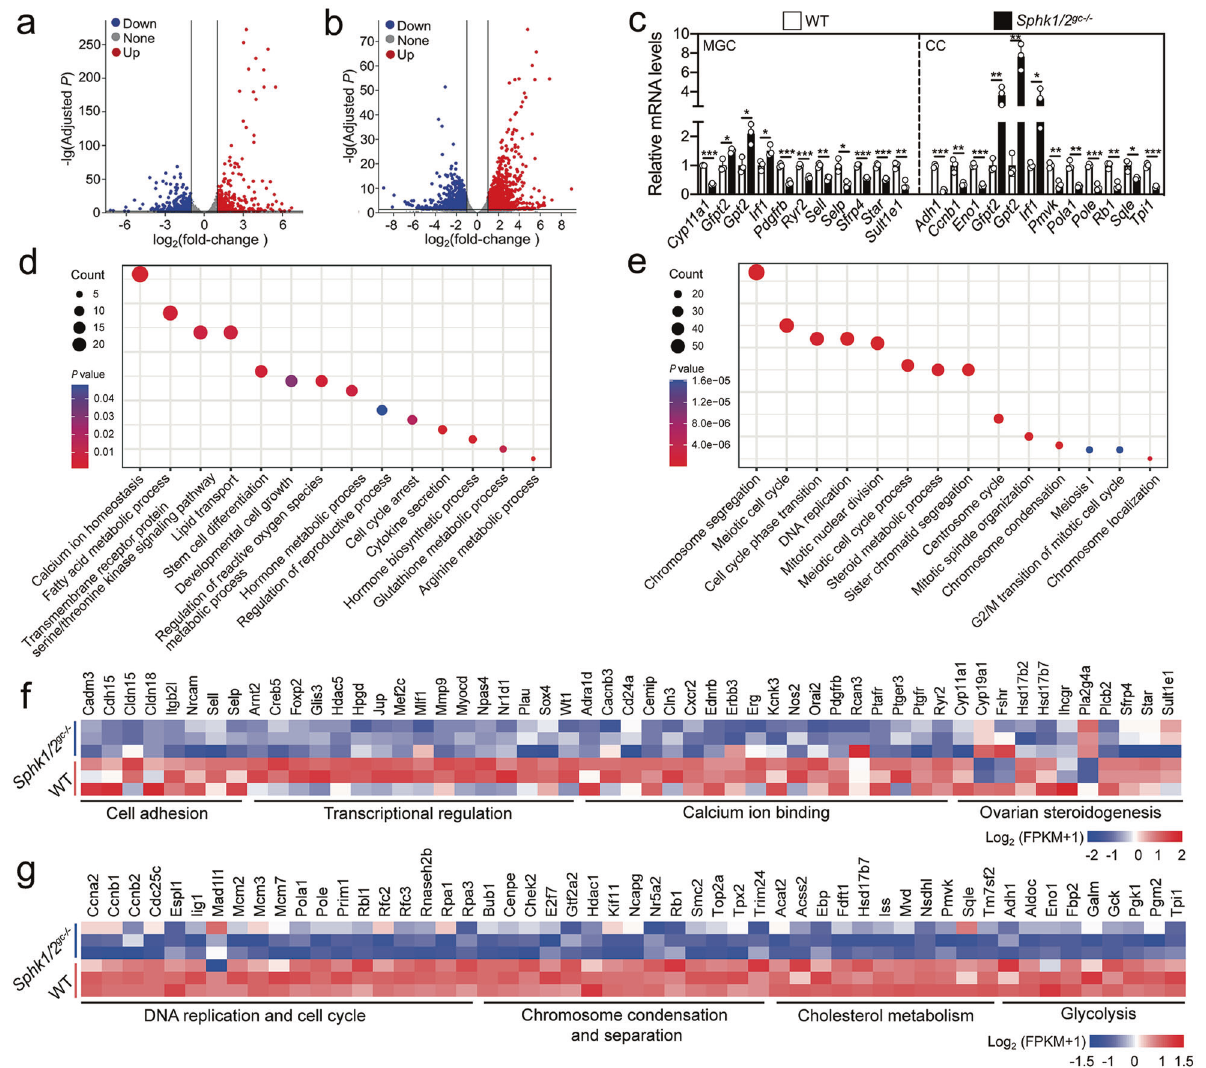
Fig. 5 Sphk1/2 depletion in granulosa cells impairs the integrity of transcriptome. a , b Volcano plot illustrating the differentially expressed transcripts in MGCs ( a ) and cumulus cells (CC, b ) isolated from WT and Sphk1/2 gc − / − mice at 2 h post-hCG. c Quantitative RT-PCR validating changes in the representative transcripts selected from RNA-seq data. ( n = 3 independent experiments). The data represent the mean ± s.d. P values were determined by a two-sided Student ’ s t -test. (* P < 0.05, ** P < 0.01, and *** P < 0.001). d , e Bubble chart illustrating the enriched GO terms associated with the signi fi cantly downregulated transcripts in Sphk1/2 gc − / − MGCs ( d ) and cumulus cells ( e ) identi fi ed by RNA-seq. Transcripts with a fold-change ≥ 2 and a P value ≤ 0.05 were selected for analysis. f , g Heatmaps illustrating differences between WT and